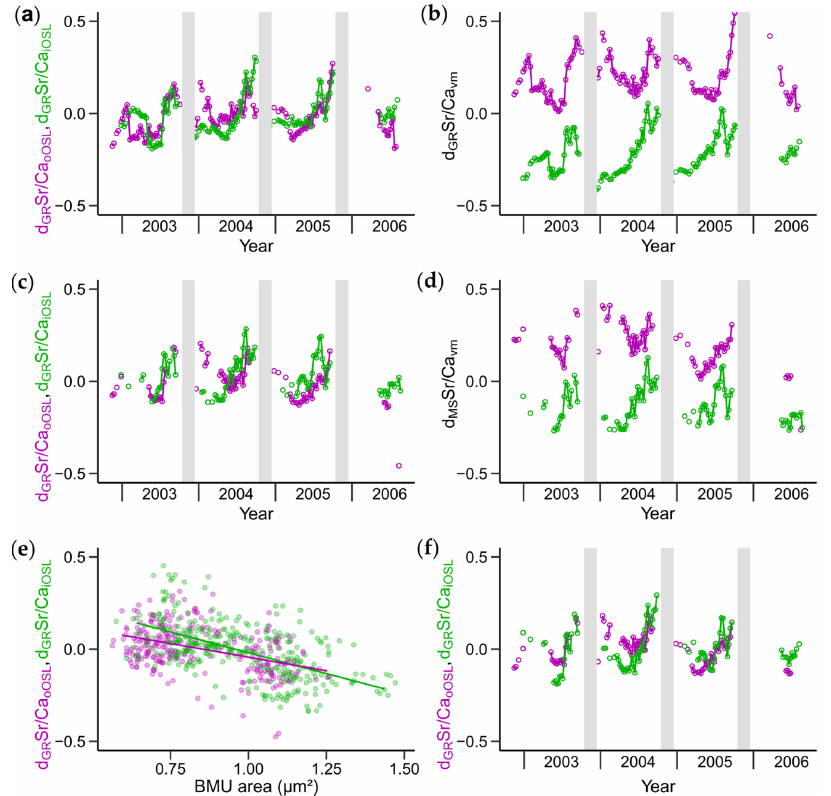
Figure 7. Detrended shell Sr/Ca chronologies of the outer and inner sublayers of the outer shell layer (oOSL, iOSL, respectively) of the ventral margin (vm) of Arctica islandica . Data represent averages of three specimens. Acronyms and color coding as in caption of Figure 3. ( a,b ) Growth rate (GR)- detrended Sr/Ca data. ( a ) Shell-sublayer-specific detrending based on non-linear models for oOSL and iOSL depicted in Figure 6a (magenta = d GR Sr/Ca oOSL ; green = d GR Sr/Ca iOSL ). ( b ) Detrending based on a regression model in which data from oOSL and iOSL (=“vm”) were combined (Figure 6a) (ma- genta = d GR Sr/Ca vm of oOSL; green = d GR Sr/Ca vm of iOSL). ( c , d ) BMU area (MS)-detrended Sr/Ca data. ( c ) Shell-sublayer-specific detrending based on linear models for oOSL and iOSL depicted in Figure 6b (magenta = d MS Sr/Ca oOSL ; green = d MS Sr/Ca iOSL ). ( d ) Detrending based on a regression model in which data from oOSL and iOSL (=“vm”) were combined (Figure 6a) (magenta = d MS Sr/Ca vm of oOSL; green = d MS Sr/Ca vm of iOSL). ( e ) Crossplot of growth-rate-detrended Sr/Ca (sublayer-specific detrending as in ( a )) vs. BMU area. ( f ) Double detrended Sr/Ca chronologies based on linear models depicted in E (magenta = GRMS Sr/Ca oOSL ; green = GRMS Sr/Ca iOSL ).